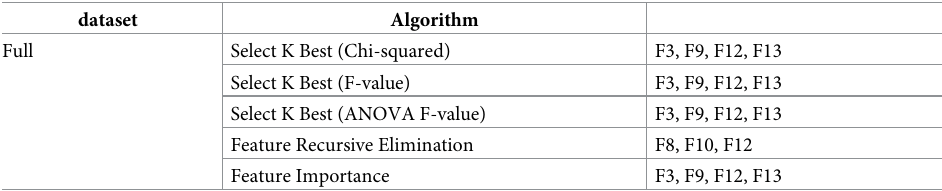
Table 8. Results of feature selection of the statlog